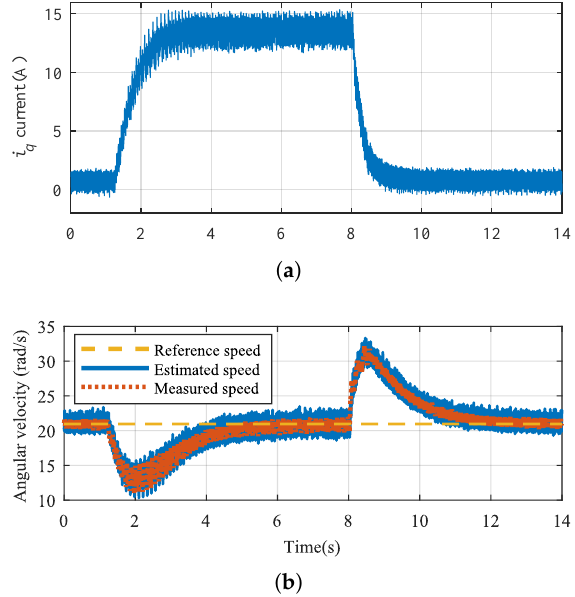
Figure 16. Loading of the motor only using the estimated position and speed. ( a ) i q current. ( b ) Reference (dashed yellow), measured (dotted orange) and estimated (solid blue) speeds.